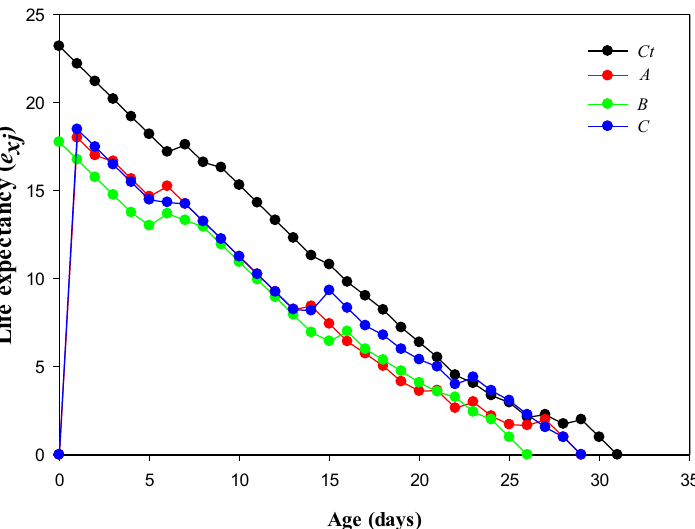
Figure 2. Transgenerational effect of lambda-cyhalothrin on Life expectancy (e xj ) of Musca domestica *Ct) control, A) LC 10 , B) LC 30 , and C) LC 50